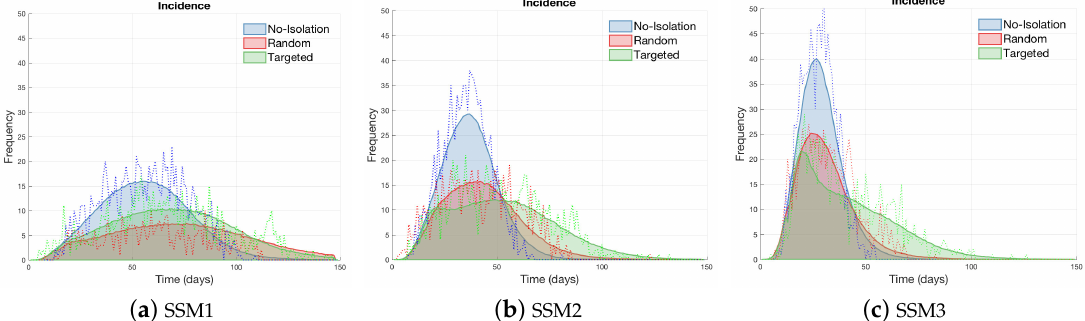
Figure 12. The impacts of two isolation strategies on the average number of MERS-CoV cases are compared without isolation ( β 0 = 0.7 is used). Random selection reduces incidence proportionally while targeted isolation reduces the peak size and delay the peak